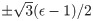
Spectral analysis of reduced linear model.(A) Cartoon of a simplified linearised rate model with three nodes x1, x2, x3 corresponding to three clusters of excitatory neurons with recurrent strength δ connected to a central cluster of inhibitory neurons x4. The cyclic connections are stronger clockwise than anticlockwise since ϵ > 1. (B) The spectrum shows a conjugate complex eigenvalue pair with large real part (2δ − ϵ − 1)/2 and an imaginary part ±3(ϵ-1)/2 which grows linearly with the asymmetry of the clockwise/anticlockwise strength (ϵ − 1). This pair of eigenvalues dominates the dynamics as their real parts are close to 1 and leads to the periodic behaviour corresponding to propagation around the cycle x1 → x2 → x3 → x1….